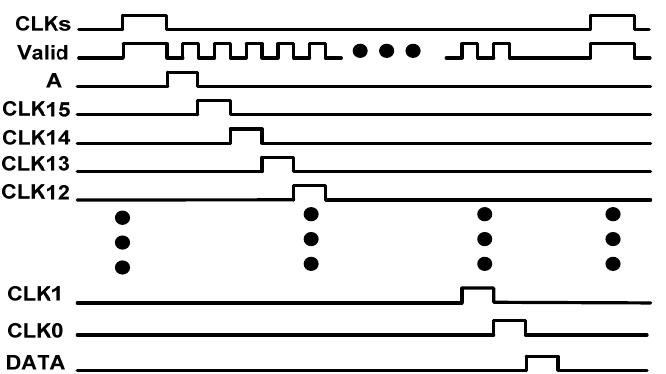
Figure 14. Asynchronous control logic.